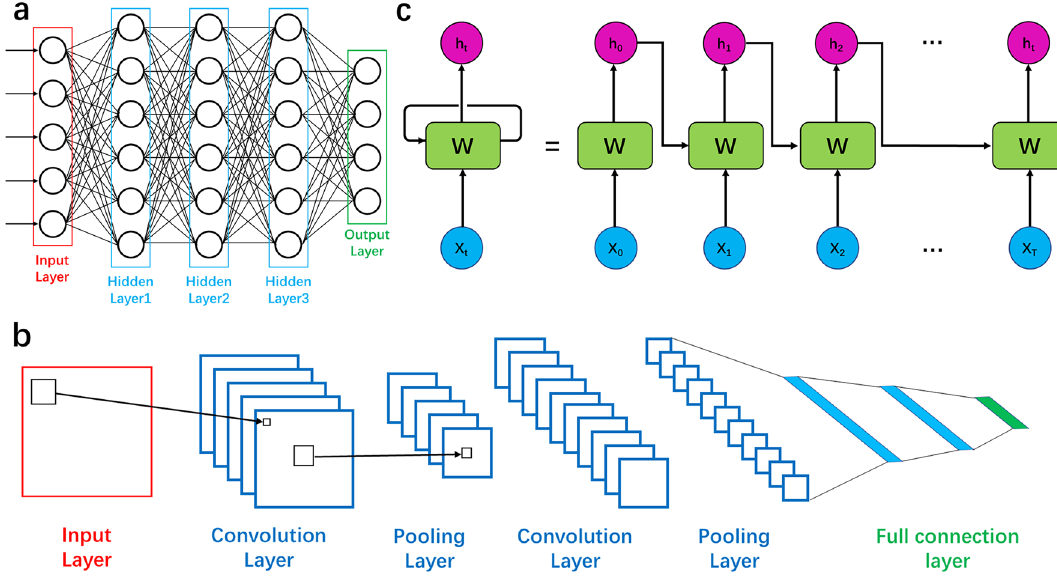
Fig. 24 Diagram of a FNN, b CNN, and c